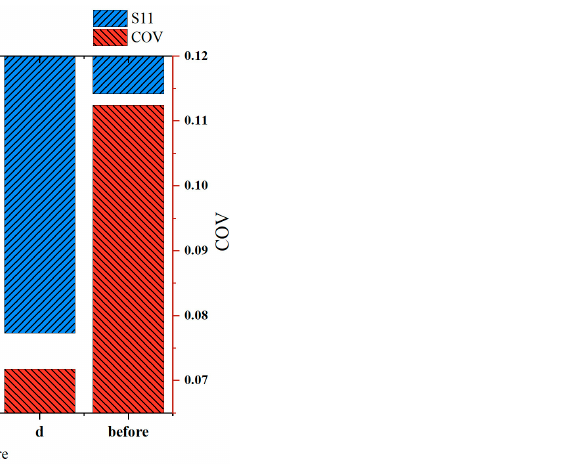
Figure 13. Reflection coefficient and heating uniformity of different structural solutions ( a – d ) represent the case after adding each of the four sawtooth structures, and ‘before’ represents the case before adding).